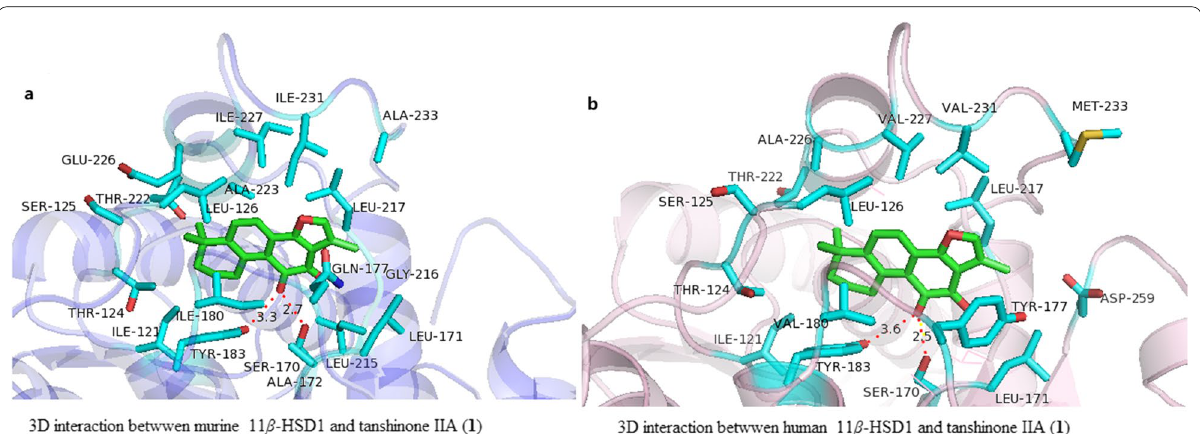
Fig. 4 Three‑dimensional (3D) interaction schemes between 1 and mouse/human 11 β ‑HSD1. The figures were prepared using PyMOL (http:// pymol. sourc eforge. net/). The ligands and the residues near the pocket are shown as sticks (receptor carbon in cyan and ligand carbon in green). a Belongs to mouse 11 β ‑HSD1 and b belongs to human 11 β ‑HSD1. Hydrogen bonds are shown as dotted lines in 3D views